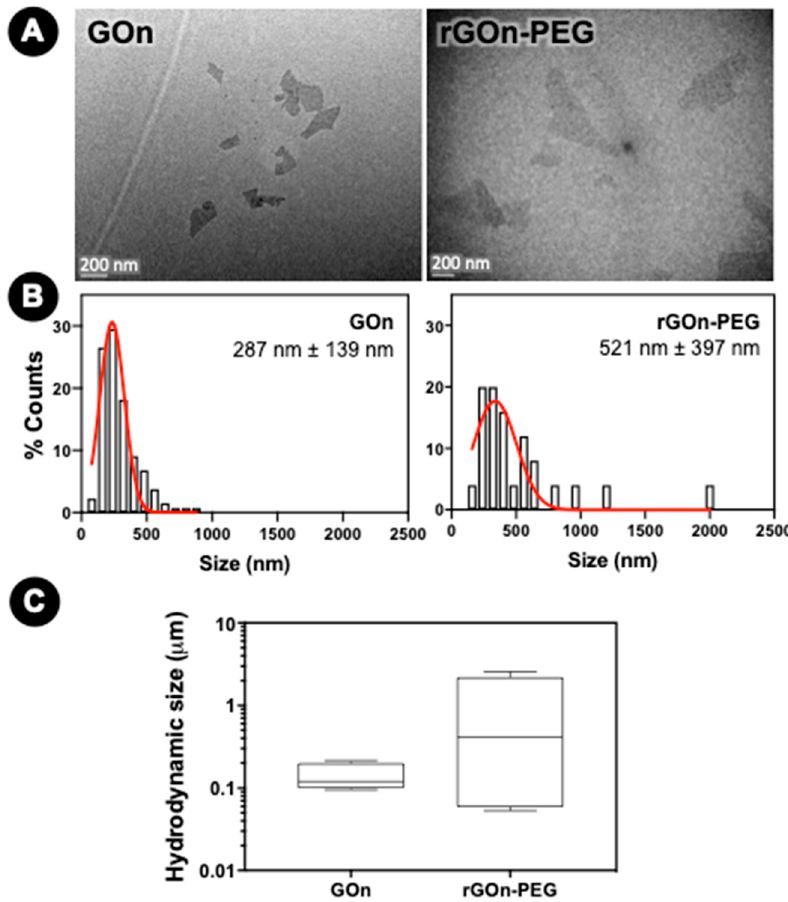
Figure 2. Morphological properties of GOn and rGOn-PEG. ( A ) Representative TEM images of GOn (left) and rGOn-PEG (right) aqueous dispersions and ( B ) respective distribution of particle size and mean and standard deviation, as determined from TEM images. Scale bar, 200 nm. ( C ) Box plot of particle size distributions in volume percentage of GOn and rGOn-PEG dispersed in water at an initial concentration of 250 µ g mL − 1 and determined by light scattering using a Coulter counter.